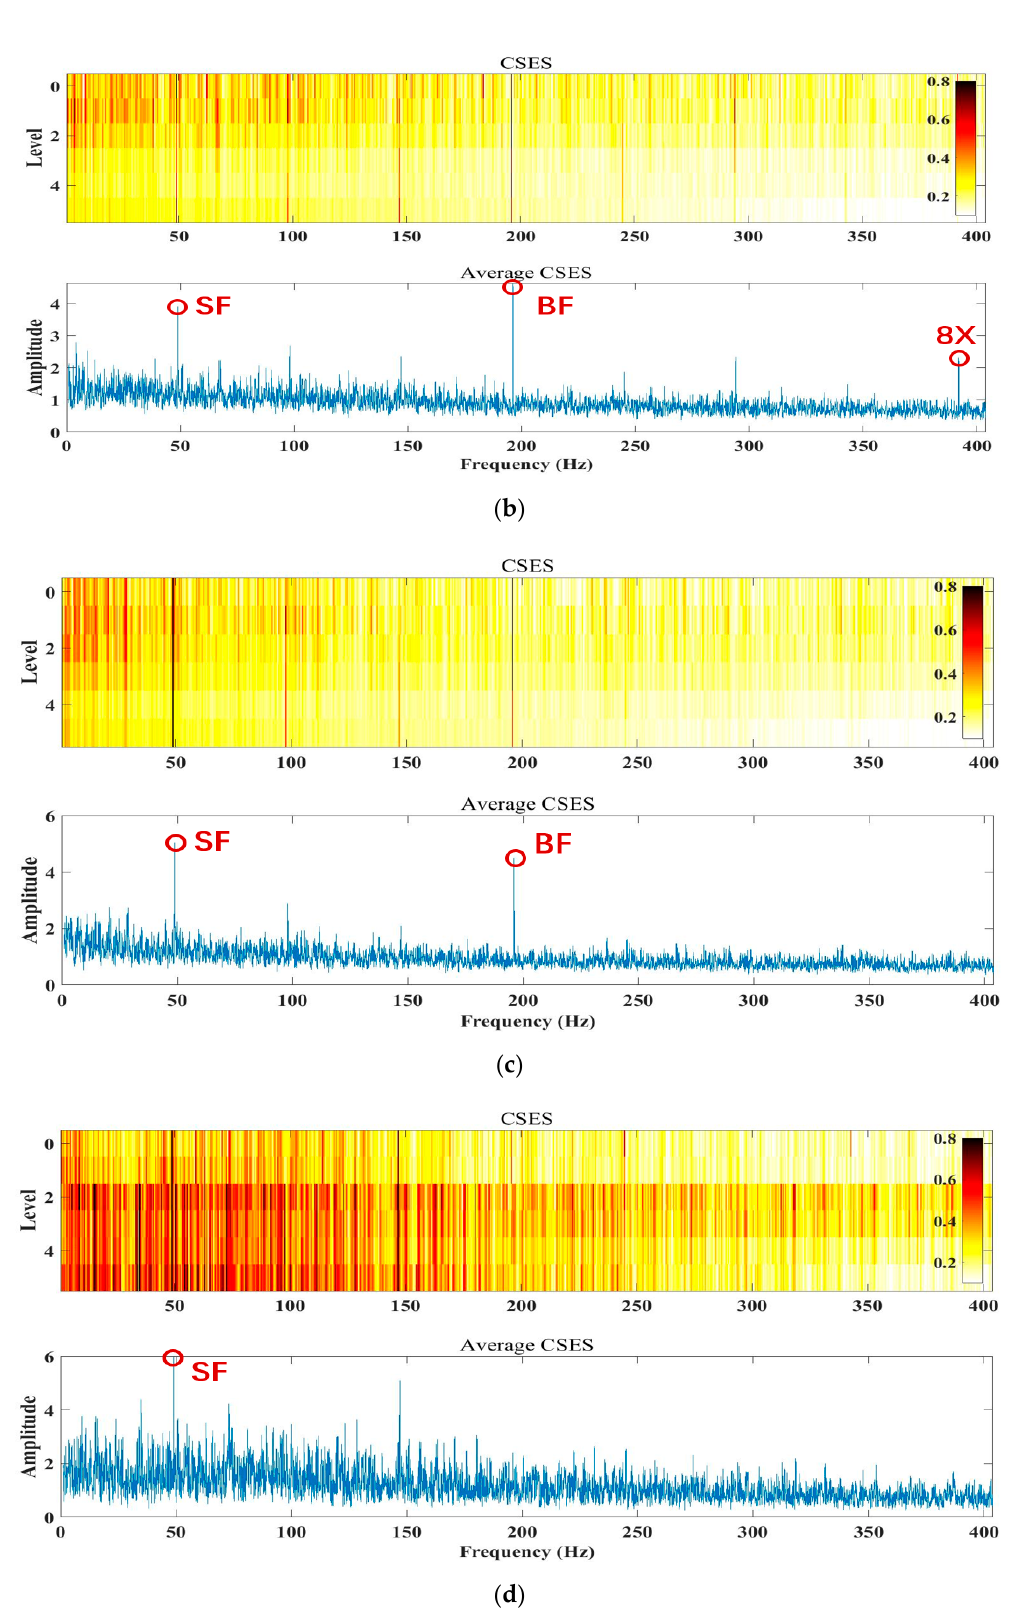
Figure 3. The combined square-envelope spectrum (CSES) and average CSES of pump vibration signals measured at Sensor 15, at Status 1, 5, 7, and 10, at a 100% flow rate: ( a ) CSES and average CSES at Status 1: No cavitation; ( b ) CSES and average CSES at Status 5: No cavitation; ( c ) CSES and average CSES at Status 7: No cavitation; ( d ) CSES and average CSES at Status 10: Severe cavitation.